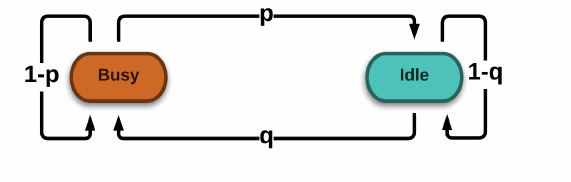
Figure 3. Effect of channel idle slot size on valid SU